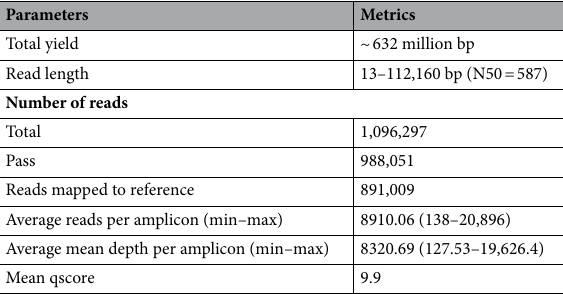
Table 1. Metrics of the nanopore sequencing